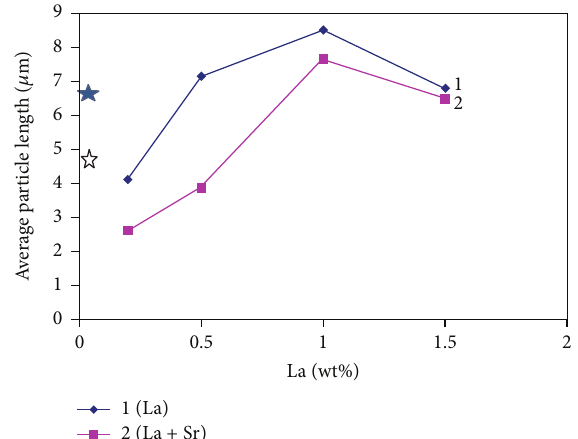
Figure 15: Effect of La and La + Sr addition on the average Si particle length in 356 alloy. (Solid star: nonmodified base alloy and open star: Sr-modified base alloy.)